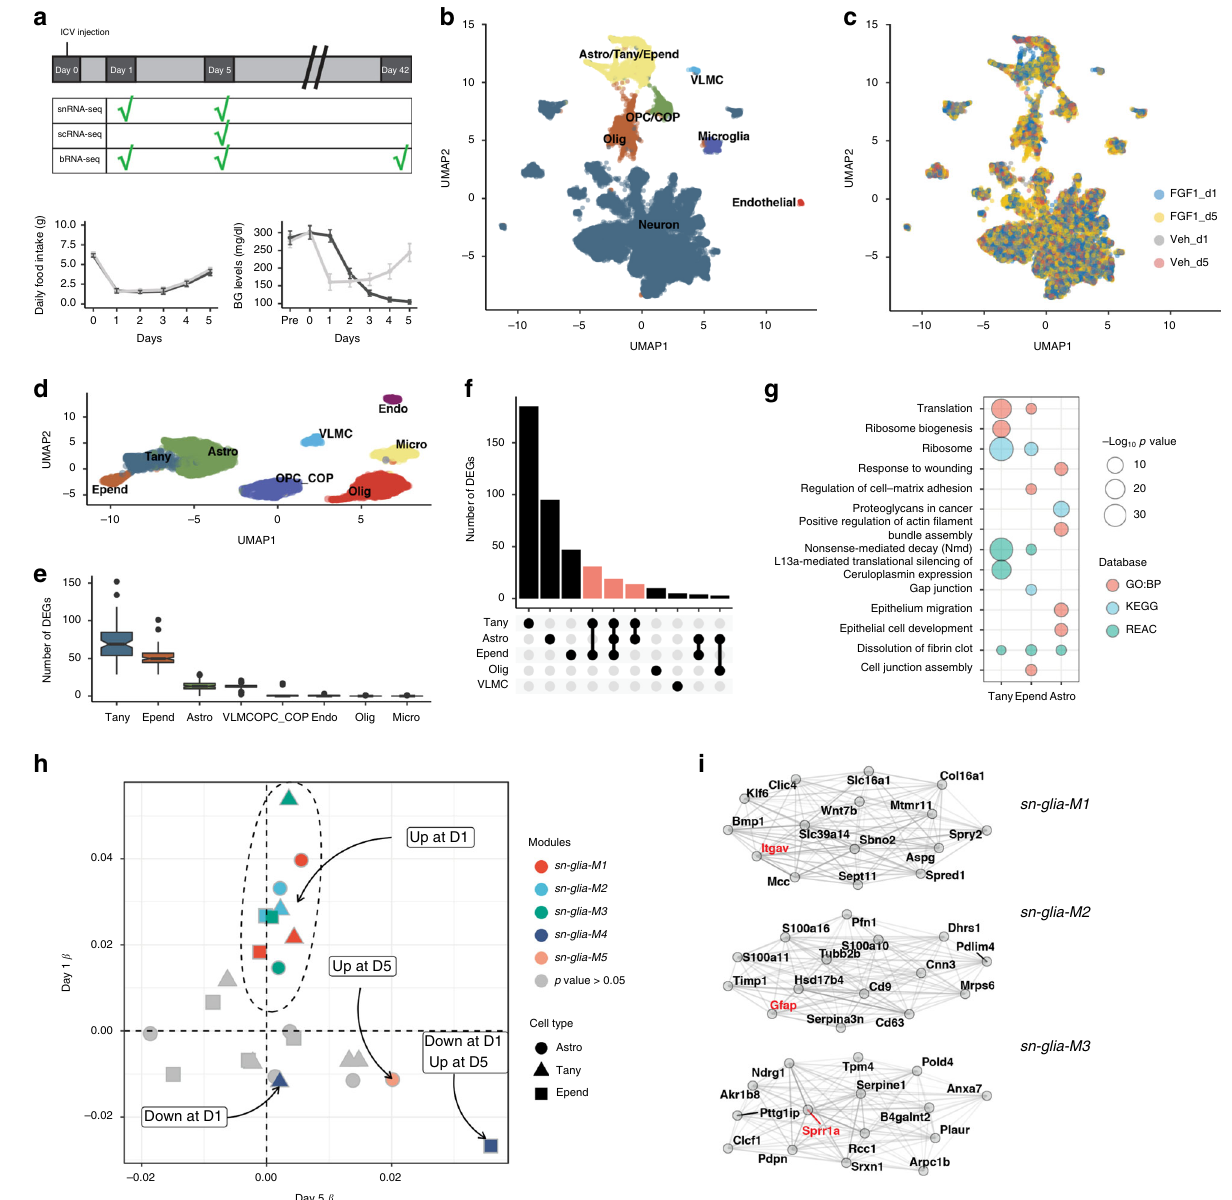
Fig. 1 Study design and icv FGF1-induced temporal glia responses. a Diabetic Lep ob/ob mice received a single intracerebroventricular (icv) injection of FGF1 (3 µ g) or vehicle at Day 0. Hypothalami were harvested on Days 1, 5, and 42 after icv injection. Vehicle-injected mice were pair-fed (PF) to the amount of food consumed by icv FGF1-injected Lep ob/ob mice and morning blood glucose levels were monitored. Plots are represented as mean ± SEM, and source data are provided as a Source data fi le; FGF1 ( n = 17), vehicle ( n = 15). b Uniform manifold approximation and projection (UMAP) clustering of hypothalamic nuclei from Day 1 and Day 5 snRNA-seq datasets. Source data are available through the NCBI Gene Expression Omnibus (GEO;